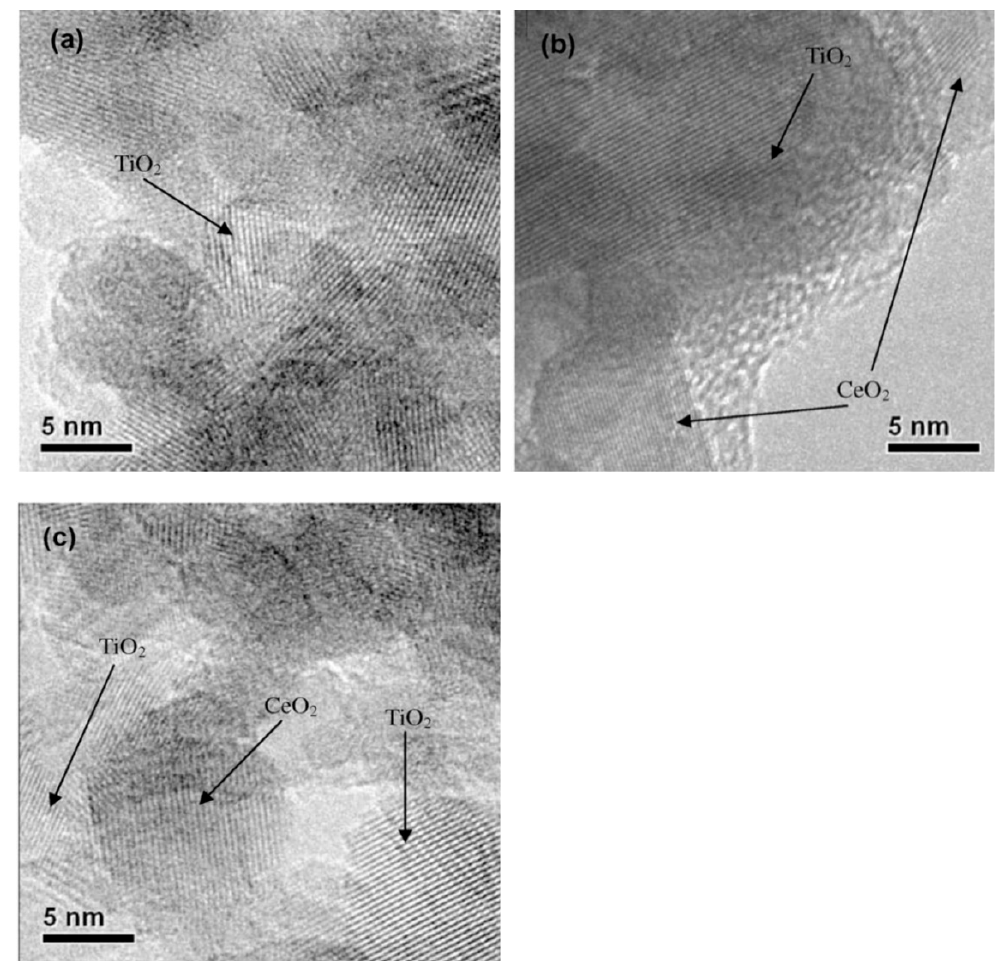
Figure 2. HR-TEM micrographs of the catalysts: ( a ) CeTi (sol–gel method), ( b ) CeTi (impregnation method) and ( c ) CeTi (coprecipitation method) [33,34].